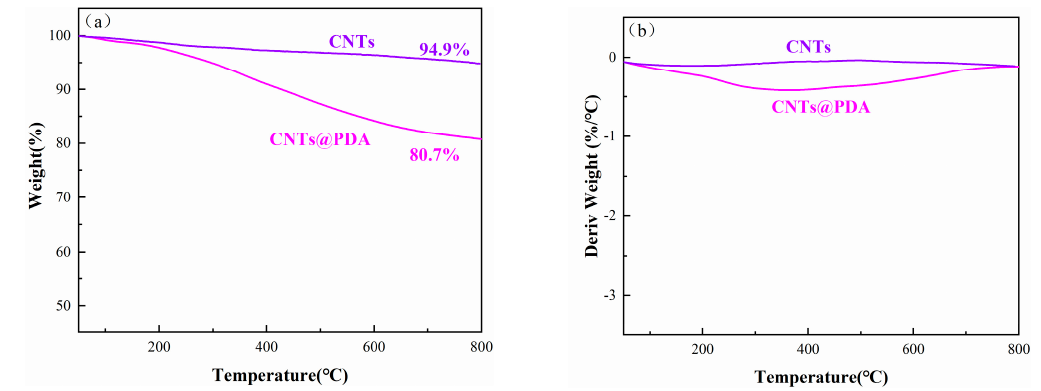
Figure 6. TGA ( a ) and DTG ( b ) curves of CNTs and CNTs@PDA.